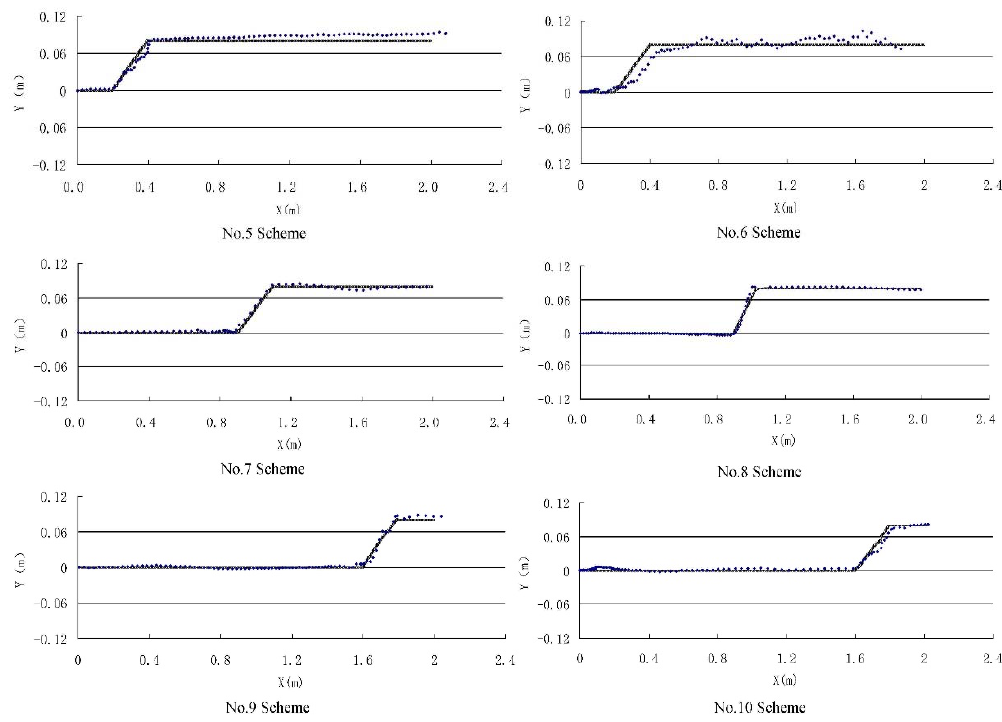
Figure 10. Results of the inclined ‐ sumping running positioning experiments.